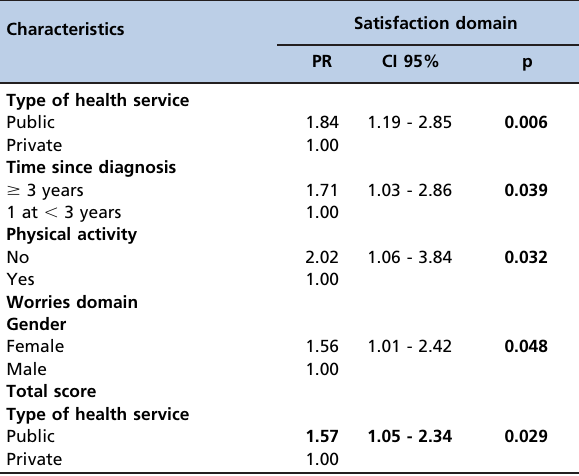
Table 4 - Sociodemographic and clinical characteristics associated with scores above the medians in the ‘‘Satisfaction’’ and ‘‘Worries’’ domains and the total